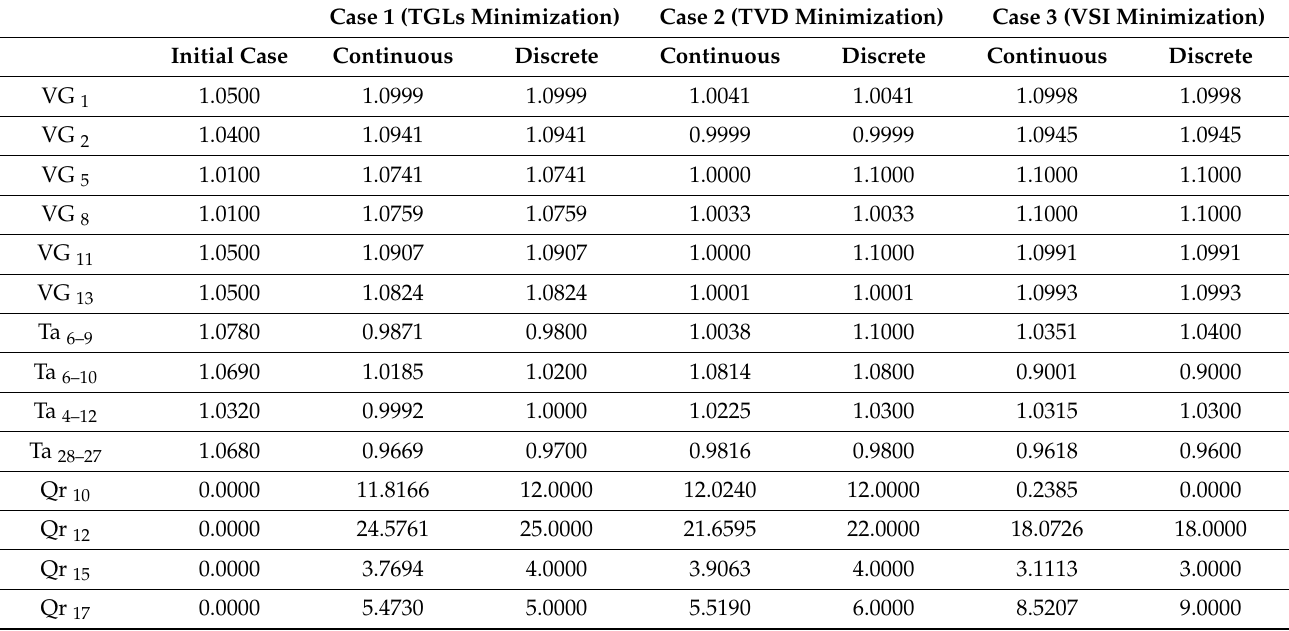
Table 6. Results for Cases 1–3 of the IEEE 30-bus grid considering the continuous and discrete nature of tap-changing transformers and shunt capacitors.